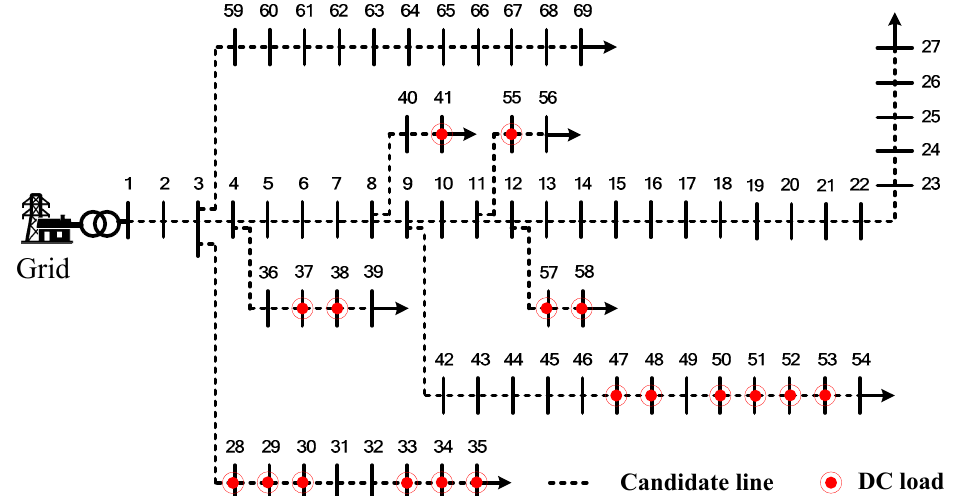
Table 11. Technical Parameters of DERs.